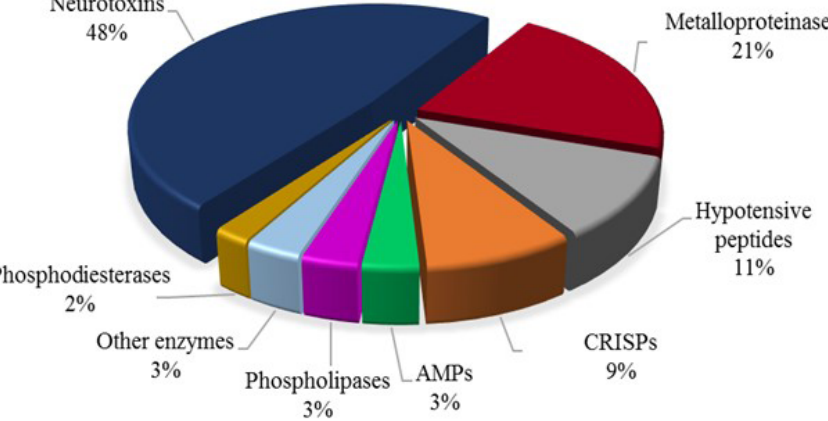
Figure 3. Relative distribution of venom protein classes in Fraction I from Ts venom determined by shotgun-proteomics. AMPs: antimicrobial peptides; CRISPs: cysteine-rich secretory proteins; Other enzymes: lysozyme, chymotrypsin and peptidylglycine alpha-amidating